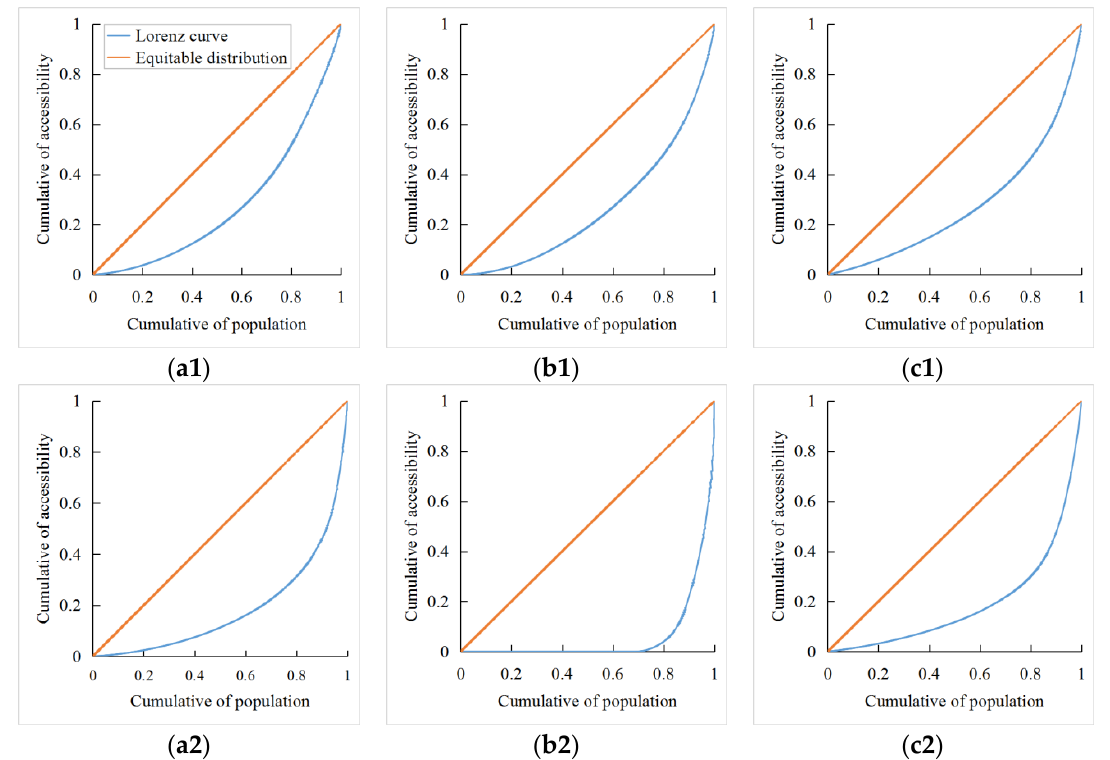
Figure 5. Lorenz curve of accessibility to ( a1 , a2 ) primary medical service (Pri_T, Pri_S); ( b1 , b2 ) secondary medical service (Sec_T, Sec_S); ( c1 , c2 ) tertiary medical service (Ter_T, Ter_S) in Shaanxi.